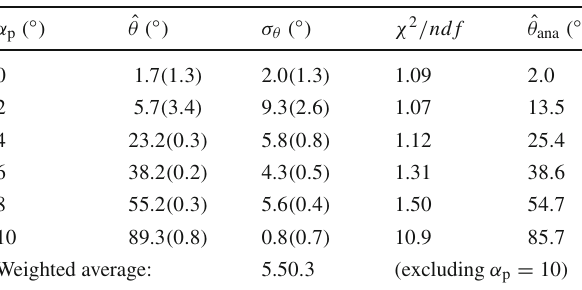
Table 3 Measured transmission functions at different plate angles α p